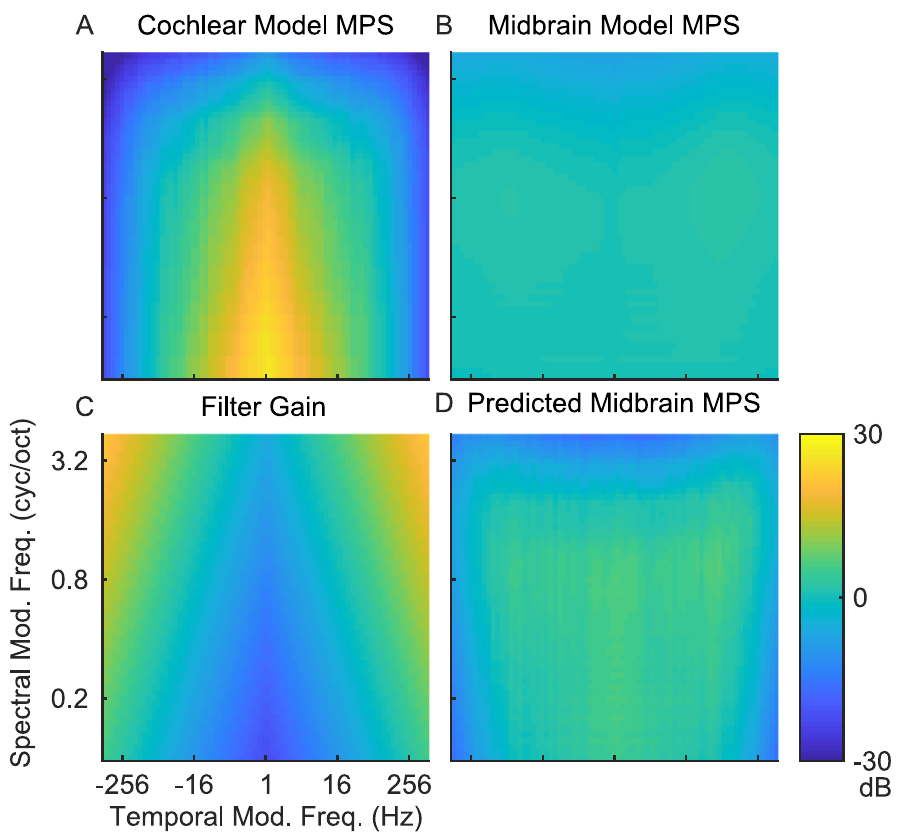
Fig 9. Modulation bandwidth scaling in the midbrain model accounts for the modulation whitening. Averaging over all sounds, the (A) cochlear model MPS overemphasizes low temporal and spectral modulations whereas the (B) midbrain model is substantially flatter MPS. (C) Residual gain of the midbrain modulation filters arising from bandwidth scaling. (D) The predicted midbrain MPS obtained by adding the Cochlear MPS (A) and bandwidth- dependent gain (C) accounts for the whitened output of the midbrain